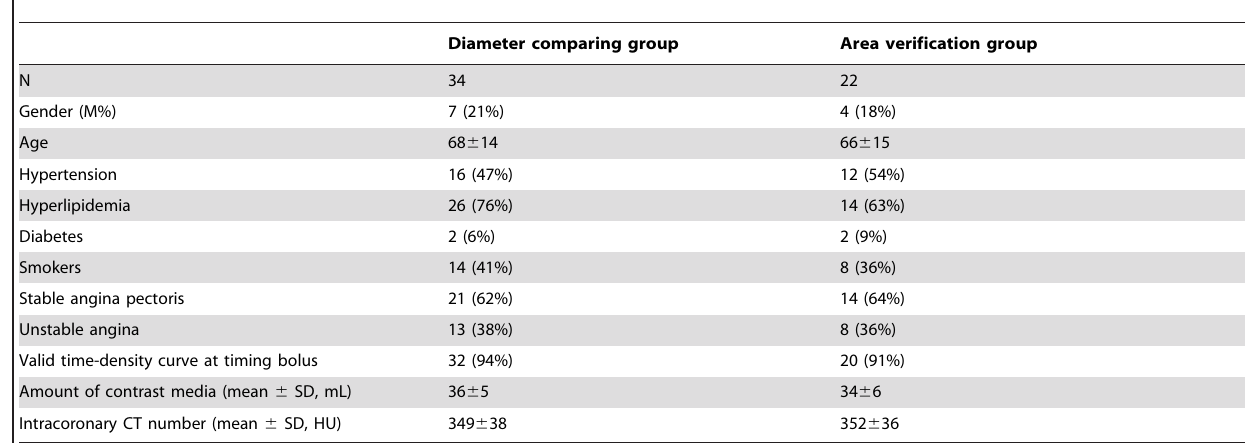
Table 1. Patient Characteristics and Coronary Computed Tomography Angiography Conditions.